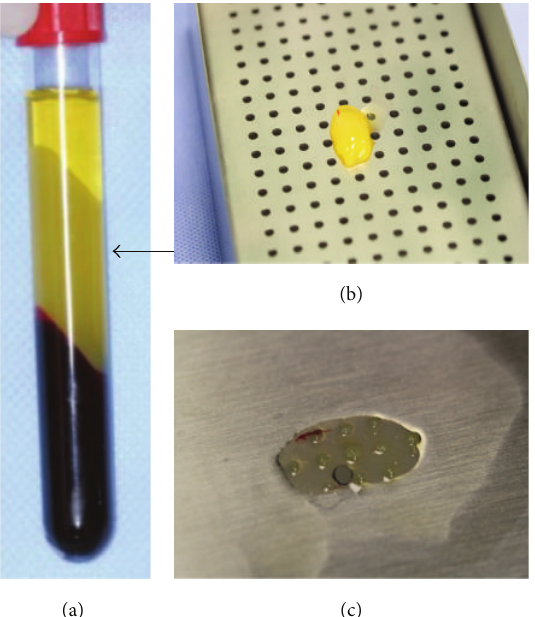
Figure 2: (a) After centrifugation, a fibrin clot (arrow) was placed between the acellular plasma layer at the top and the red corpuscles at the bottom of the tube. (b) Removal of the PRF clot from the tube using forceps. (c) PRF membrane obtained by compressing the PRF clot with PRF membrane box.